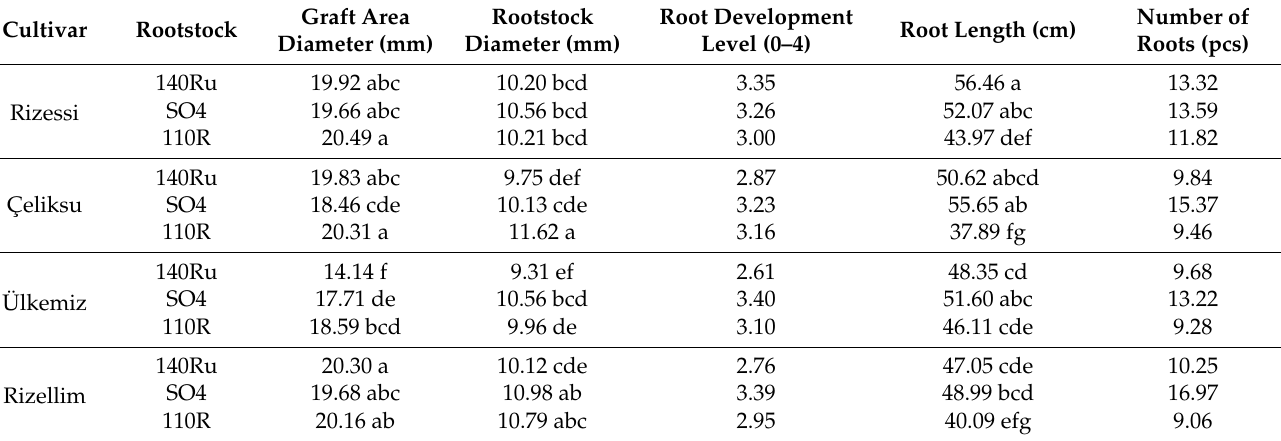
Table 3. Sapling rate and quality criterias of foxy grape varieties ( V. labrusca L.) grafted on different